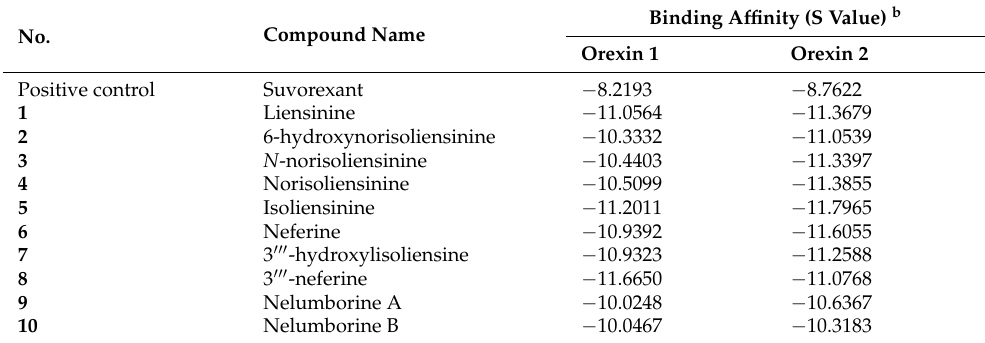
Table 1. The top 10 binding affinities (S value) between compounds and orexin 1/2